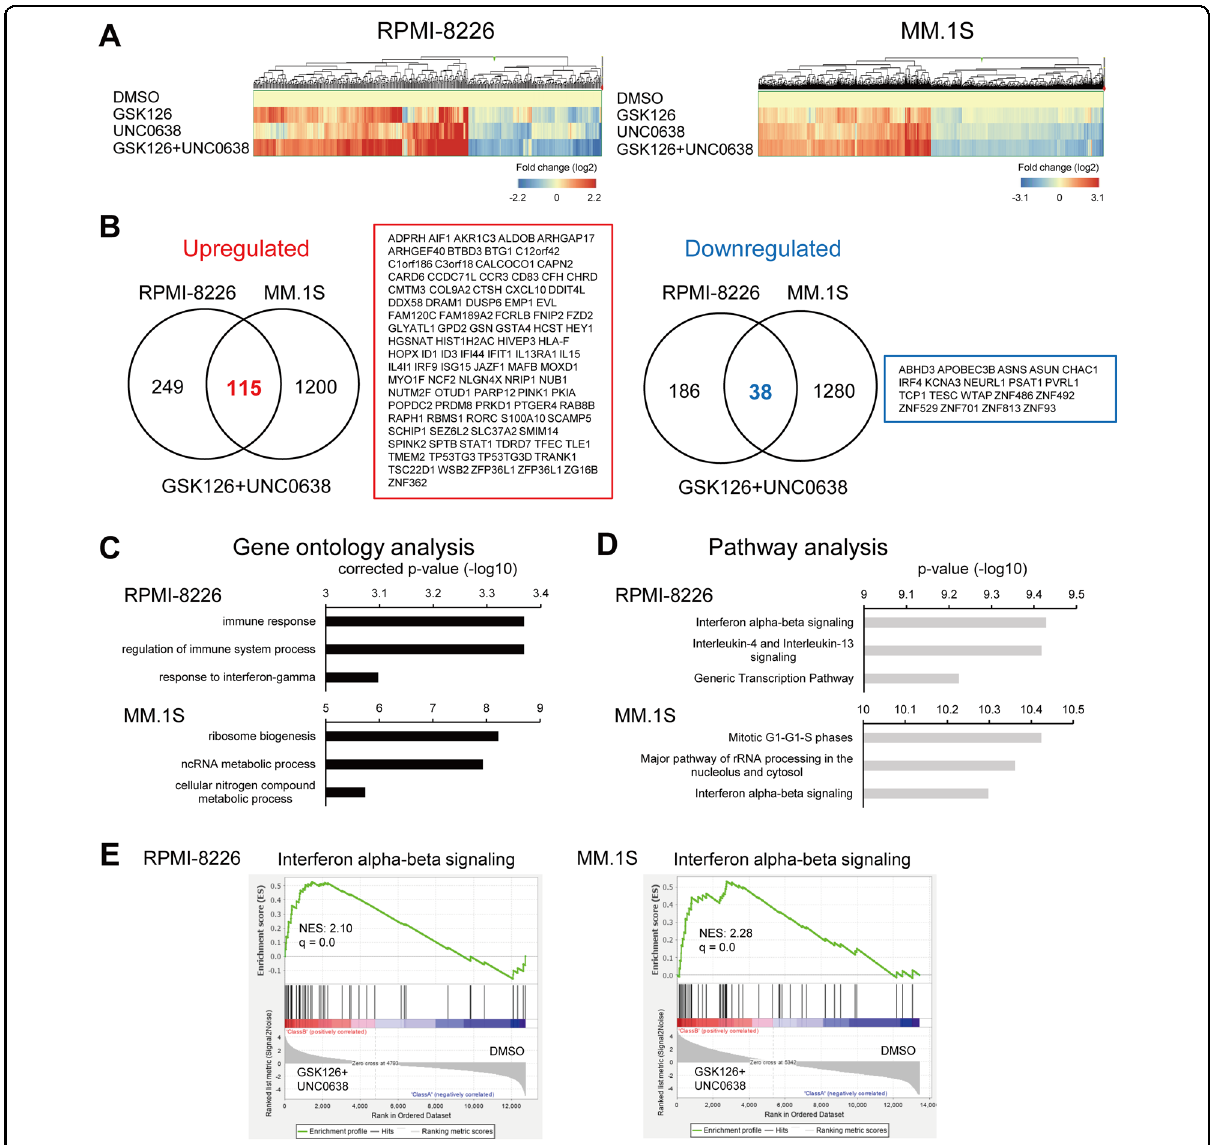
Fig. 3 Analysis of gene expression in MM cells after EZH2 and G9a inhibition. A Heat maps for the genes whose expression was altered in MM cell lines by the indicated drugs (1 μ M each, 6 days). Shown are means of two biological replications. B Venn diagrams of genes upregulated (left) or downregulated (right) by GSK126 + UNC0638 in two MM cell lines. Genes upregulated or downregulated in both cell lines are listed in boxes on the right. C , D Gene ontology ( C ) and pathway analyses ( D ) of genes altered by GSK126 + UNC0638 (>2-fold) in MM cell lines. E GSEA of the genes involved in interferon α and β signaling using the microarray data from the indicated MM cell lines treated with DMSO or GSK126 +